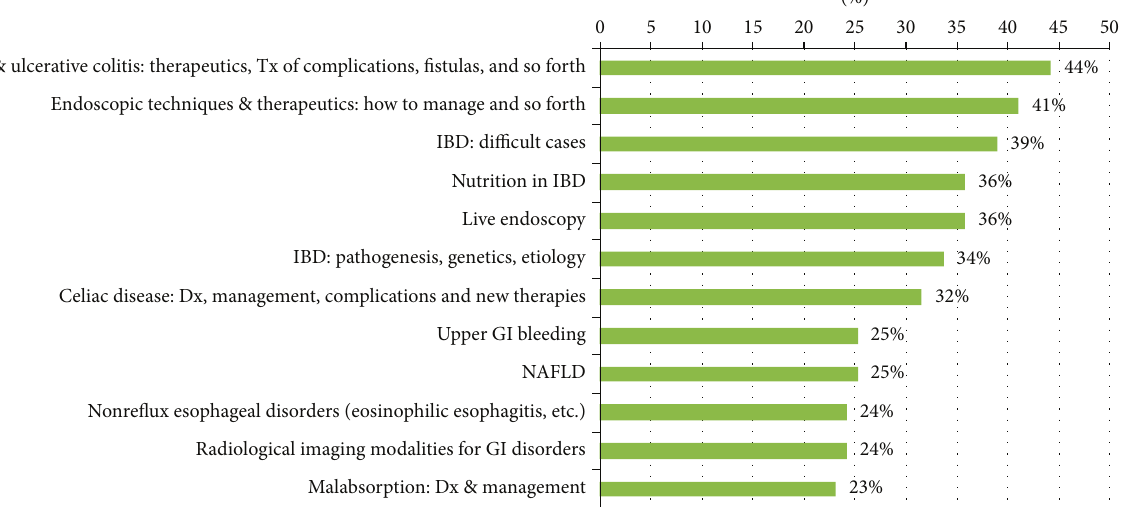
Figure 1: The 12 most popular topics for educational events based on the percent of respondents who were “very interested” in the area (23– 44% very interested). Crohn’s disease; Dx: diagnosis; NAFLD: nonalcoholic fatty liver disease; GI: gastrointestinal; IBD: inflammatory bowel disease; Tx: treatment.